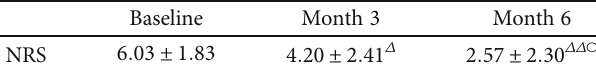
Table 4: Change in neuropathic pain severity. Table 2: Demographic and patient characteristics at